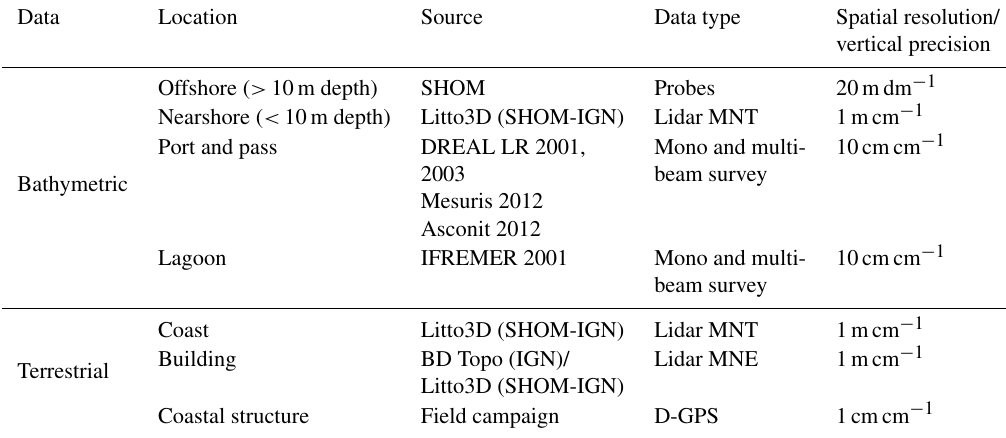
Table 2. Topobathymetric